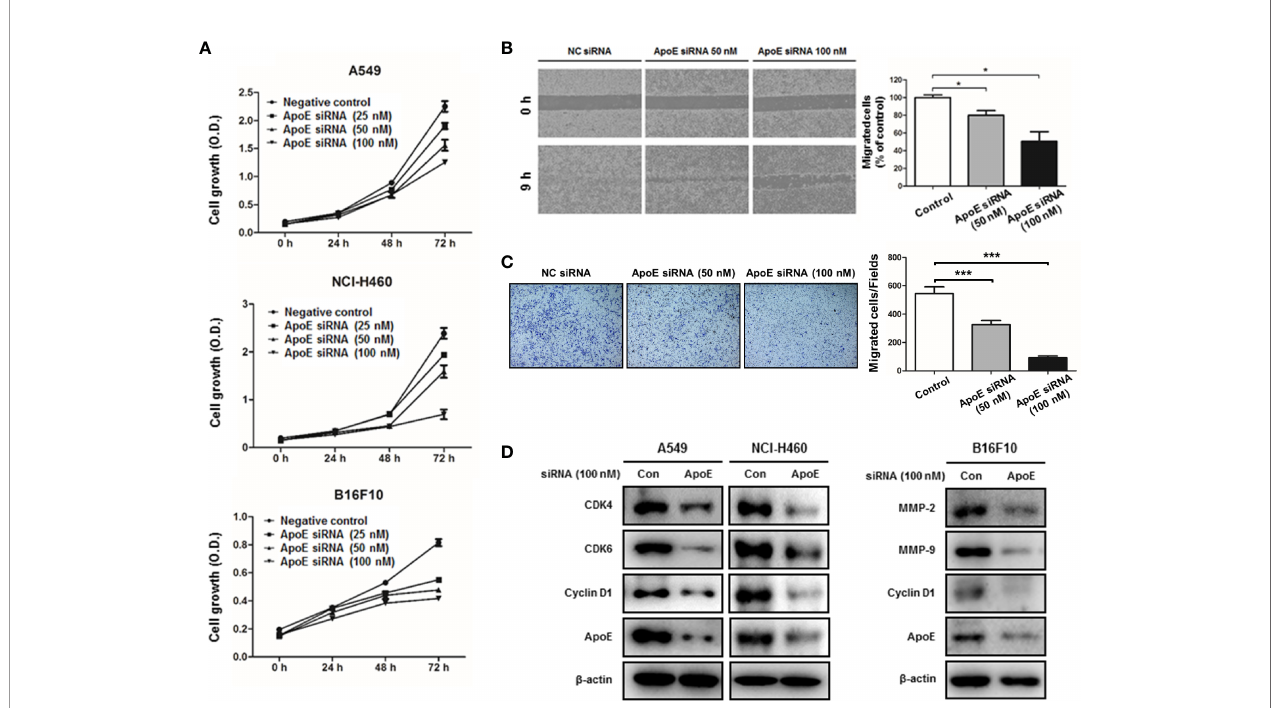
FIGURE 3 | Effect of ApoE knockdown on cell growth and migration in cancer cells. (A) Lung cancer cells (A549 and NCI-H460) and B16F10 cells were plated on 96-well plates (1x10 3 cells per well) and transfected with the negative control (NC) siRNA or ApoE siRNA (25, 50 or 100 nM) for indicated time points. Cell growth was measured by MTT assay ( n =5). (B) B16F10 cells were seeded on m -Slide and transfected with NC siRNA or ApoE siRNA (50 or 100 nM). Cells were cultured to con fl uent on m -Slide ( n =3). After silicon-wall removal, cells were allowed to migrate into cell-free zone. Cell migration was detected at various times post-silicon-wall removal by a microscopy at 100X. (C) B16F10 cells transfected with NC siRNA or ApoE siRNA (50 or 100 nM) were seeded onto transwell inserts pre-coated with collagen on the bottom side and loaded into culture well fi lled with growth medium containing 10% FBS as a chemoattractant ( n =3). After 18 h incubation, transwell inserts were fi xed and stained by crystal violet solution. Bar graphs represent cell-migration distance or number of migrated cells. * p < 0.05 and *** p < 0.0001. (D) Cells were transfected with NC siRNA or ApoE siRNA (100 nM) for 24 h. Cell extracts were analyzed by Western blotting. Samples (30 m g) were resolved on SDS – PAGE and detected with speci fi c antibodies against CDK4, CDK6, Cyclin D1, MMP-2, MMP-9 and ApoE. b -actin was used as a loading